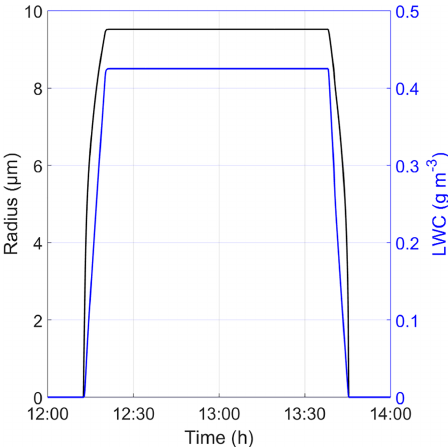
Figure 3. Time evolution of the mean cloud droplet radius (left axis) and cloud liquid water content (right